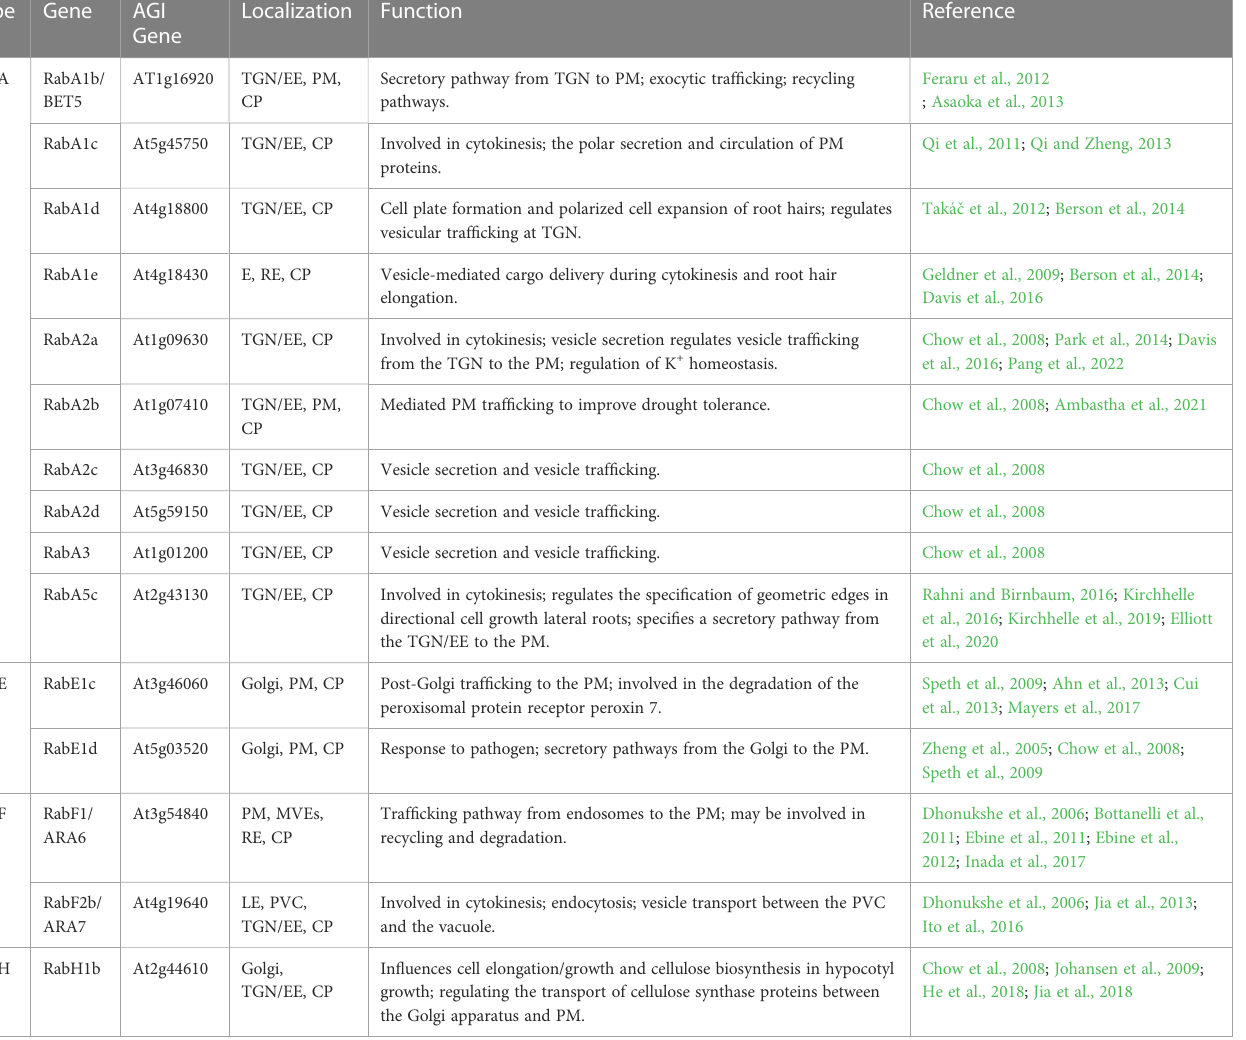
TABLE 1 Characteristics of Rab GTPases located in cell